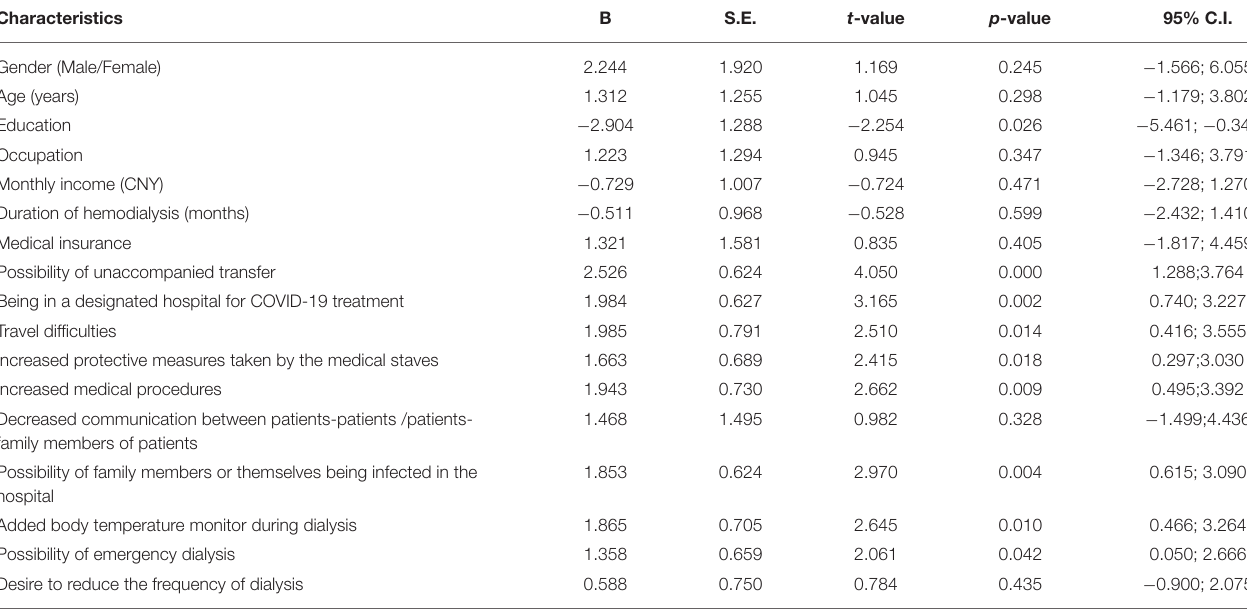
TABLE 3 | Univariate linear regression analysis of factors predictive of elevated anxiety symptoms during the early COVID-19 pandemic. Characteristics B S.E. t -value p -value 95% C.I.